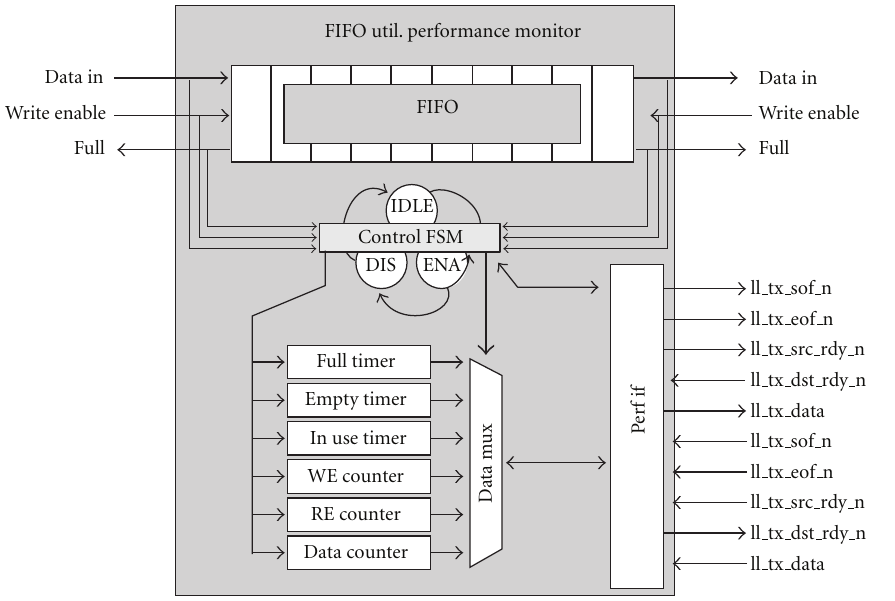
Figure 8: Block diagram of performance monitor interface connecting to a simple configurable timer monitor.